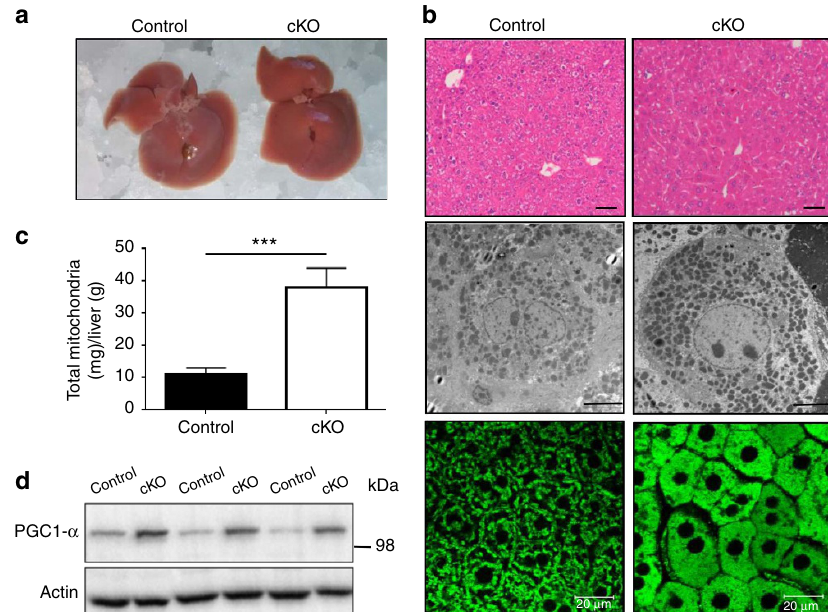
Figure 2 | Increases in mitochondrial numbers in the Ant2 cKO liver. ( a ) Representative images of liver gross appearance ( n ¼ 10), ( b ) Representative images of H&E staining, Scale bar; 40 m m (upper panel), transmission electron microscopy analysis Scale bar; 5 m m (middle panel) and multiphoton microscopy analysis after the liver was perfused with Rhodamine-123 Scale bar; 20 m m (lower panel; n ¼ 5), ( c ) mitochondrial mass per gram of